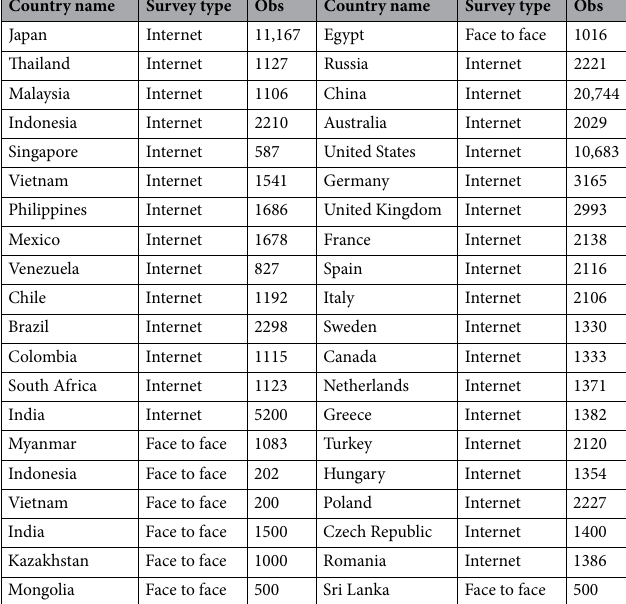
Table 1. Survey type and number of observations in 37